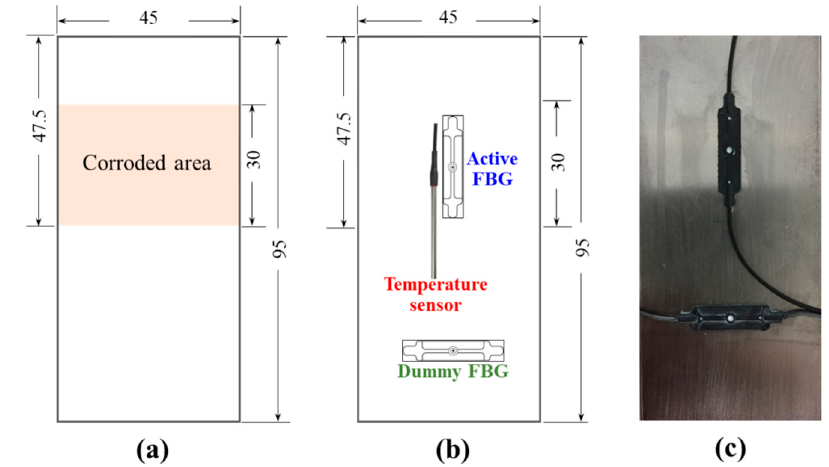
Figure 3. Configuration of active and dummy fiber Bragg grating (FBG) sensor on the ( a ) front side and ( b ) back side of the test piece. ( c ) The actual figure of the FBG sensors attached to the test piece. The unit is in mm.